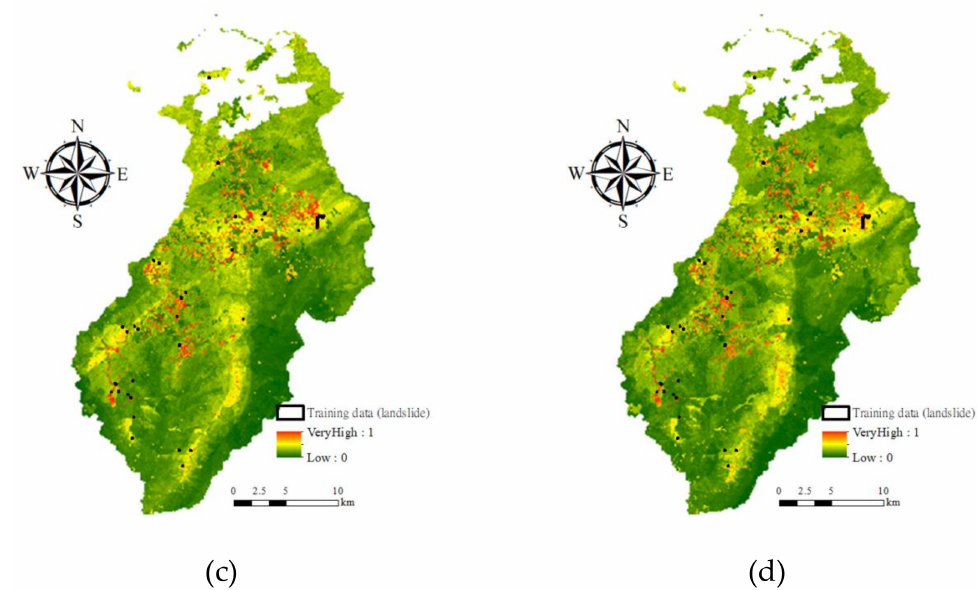
Figure 12. The landslide susceptibility maps generated for Typhoon Sinlaku ( a ) with cost = 50 in the 1:1 case, ( b ) with cost = 300 in the 1:4 case, ( c ) with cost = 500 in the 1:7 case, and ( d ) with cost = 700 in the 1:10